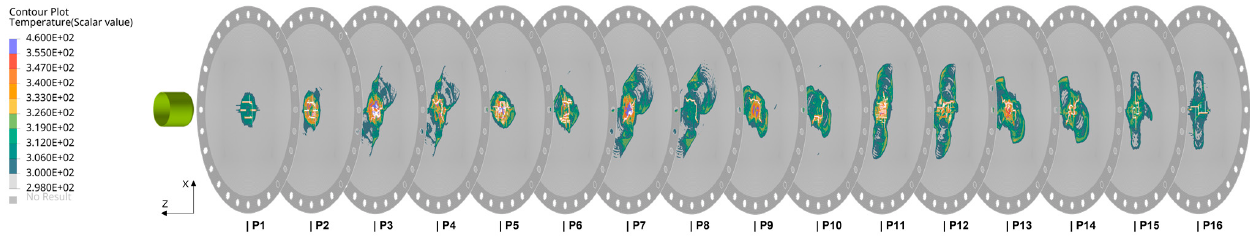
Figure 10. Global thermal distribution at 2 ms for all the composite plies (Unit Kelvin).